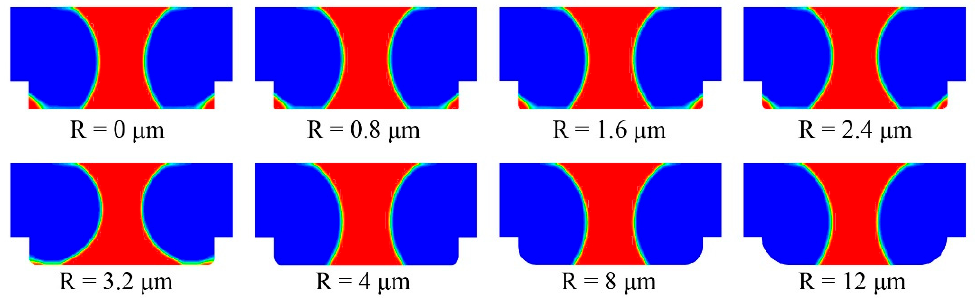
Figure 13. Volume fraction diagram of fluid transfer process when α = 30°, β = 60°, h = 12 μ m, and t = 30 μ s.